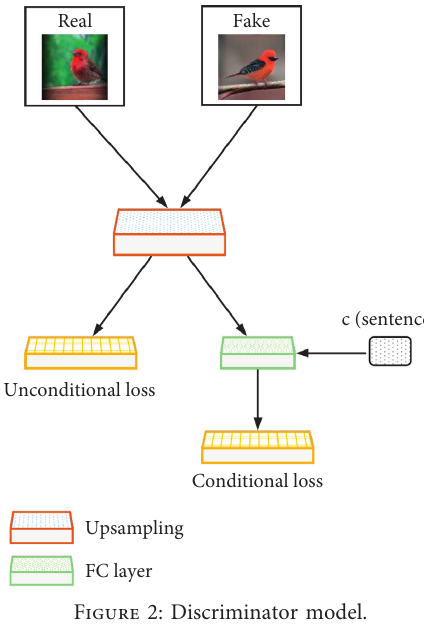
Figure 2: Discriminator